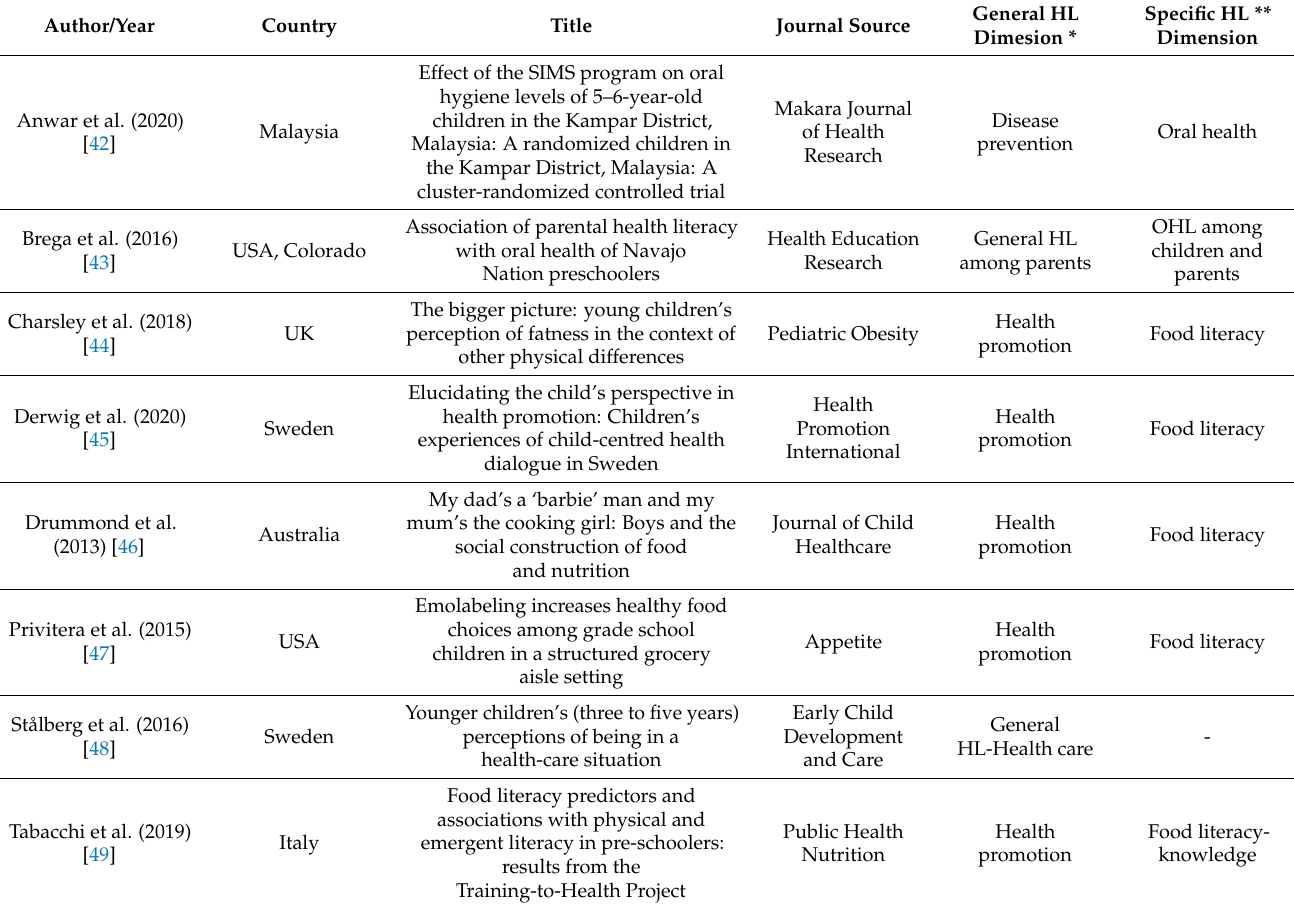
Table 1. Selected empirical studies and the HL dimension